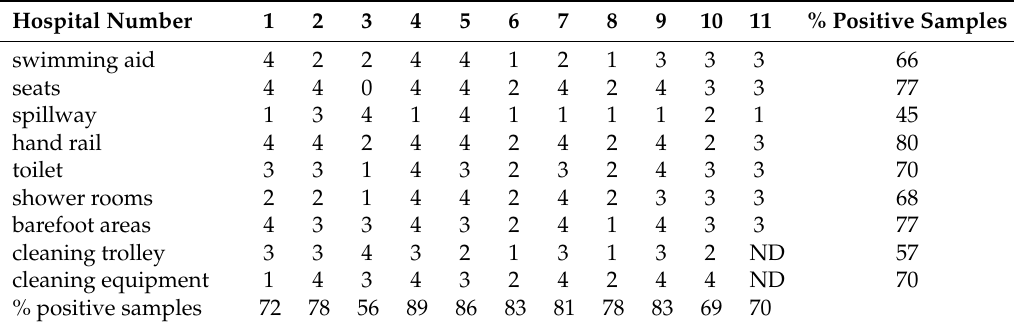
Table 4. Number of positive samples from contact agar plates and percentage of positive samples ( n =